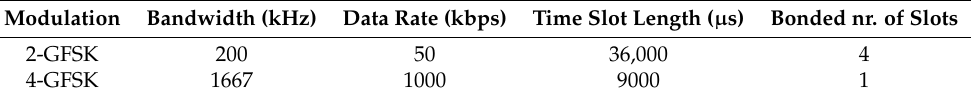
Table 1. The used PHYs configurations, together with their configured time slot length and number of bonded regular slots.